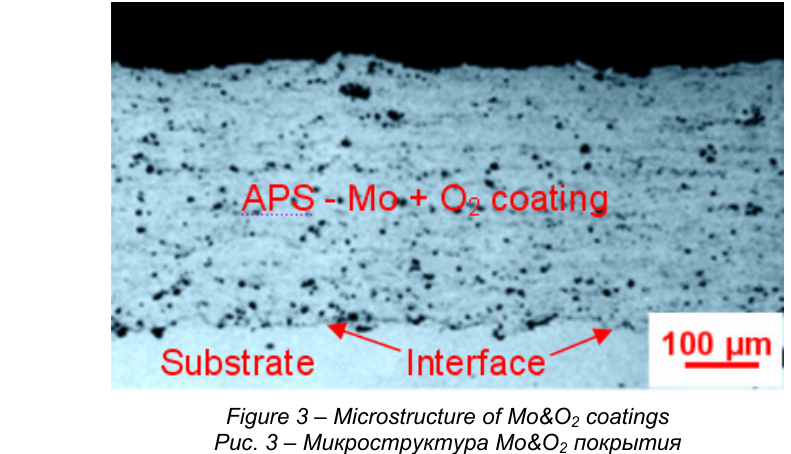
Figure 3 – Microstructure of Mo&O 2 coatings Рис . 3 – Микроструктура Mo&O 2 покрытия Слика 3 – Микроструктура Mo&O 2